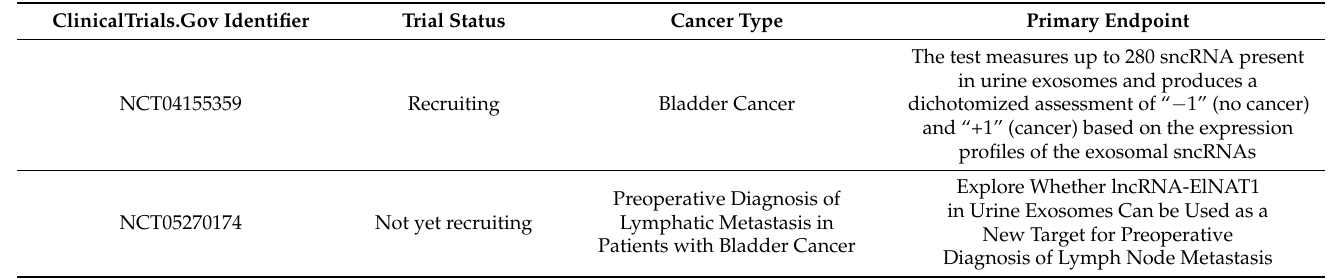
Table 3. Clinical Trials Utilizing Extracellular Vesicles and Exosomes as Biomarkers for Bladder Cancer Diagnosis. Information is from searching via